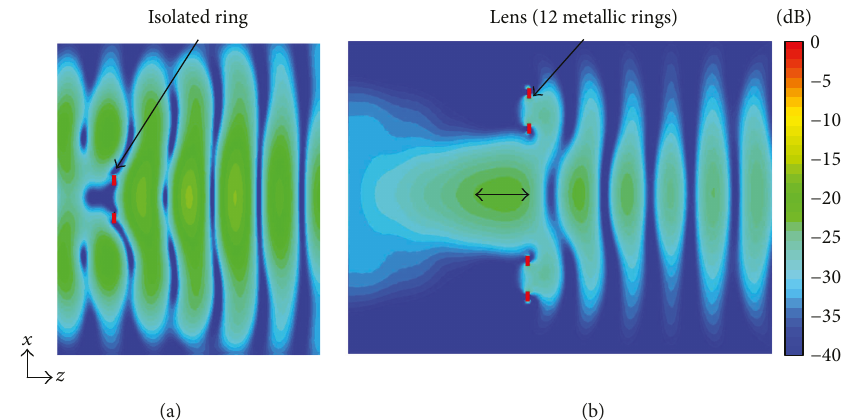
Figure 3: Simulation of an incident plane wave at 10 GHz in (a) a metallic ring (unit cell) and (b) the proposed lens antenna. Color scale is valid for both